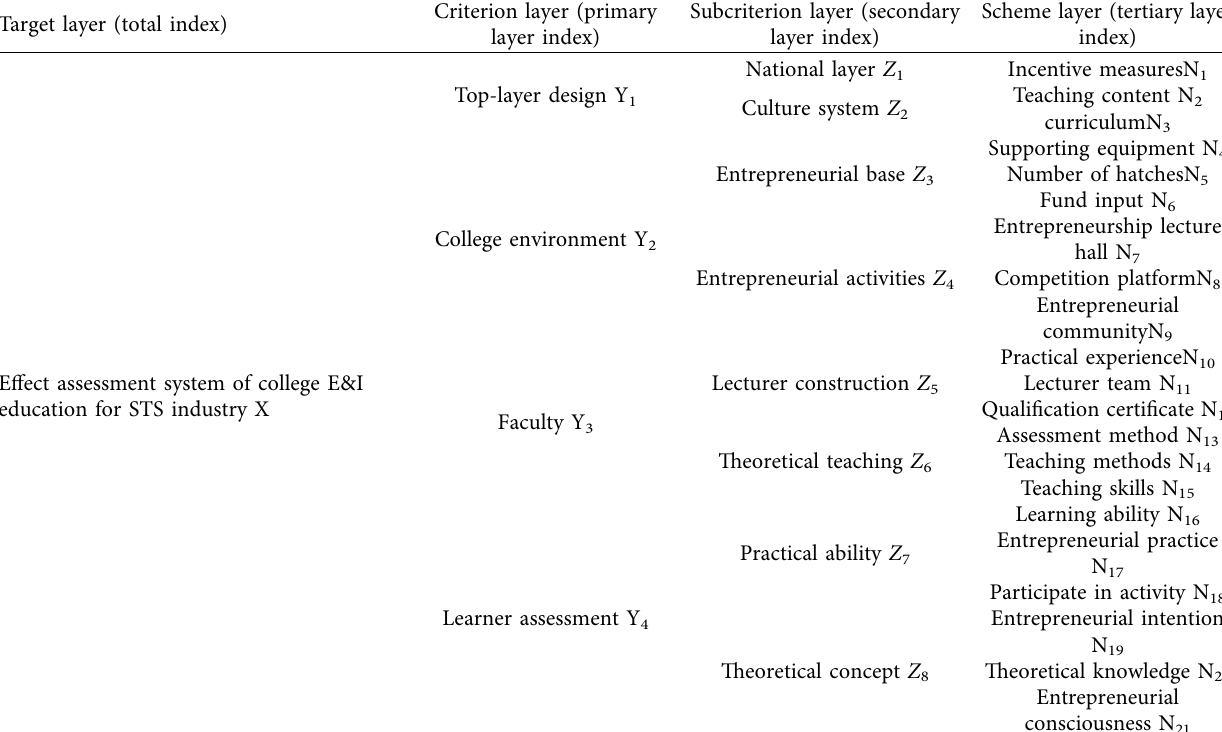
Table 4: Effect assessment system of college E&I education for STS